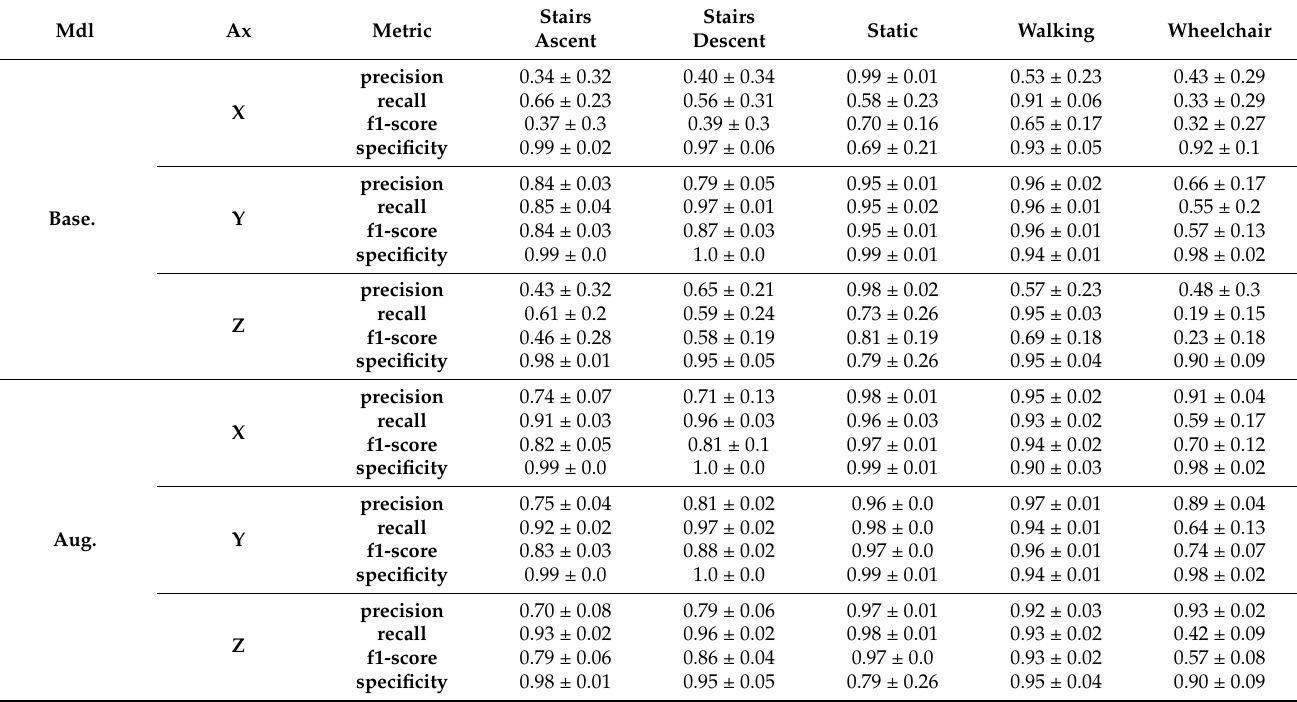
Table A7. Single class results of baseline and augmented model for the fully-rotated test set on every axis. Considered data: WPS holdout participants.